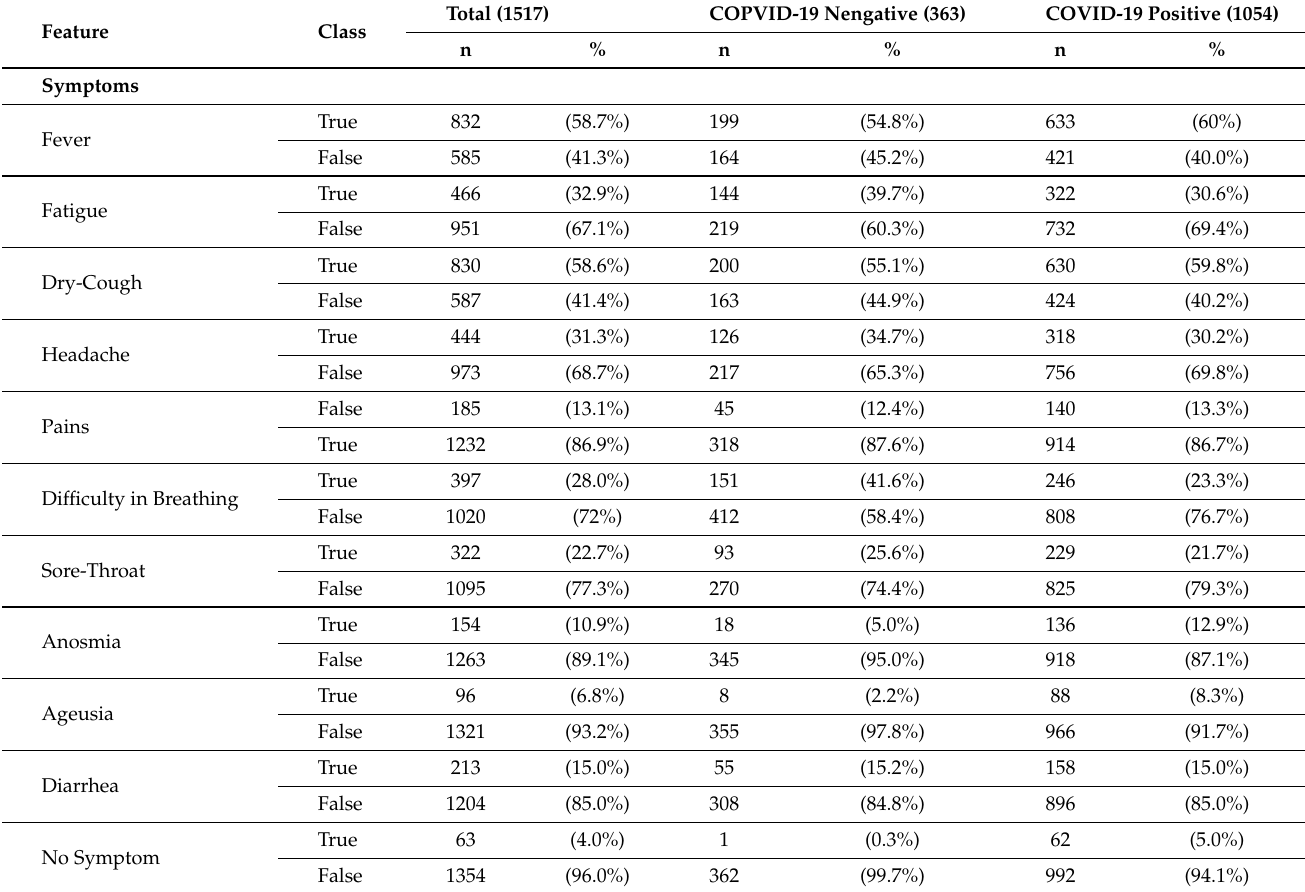
Figure 5. Scatter plot showing correlations between 19 selected features. Table 2. Characteristics and descriptions of the features used in this